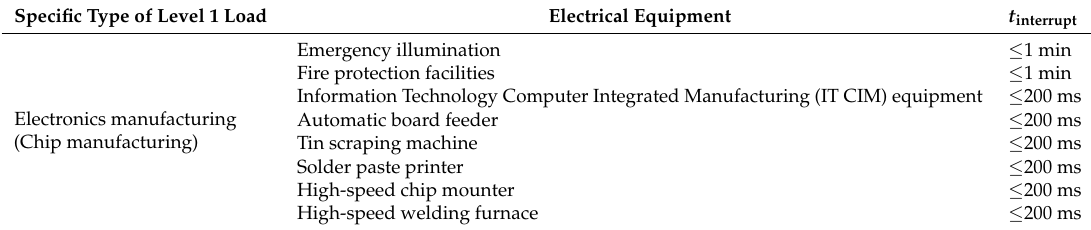
Table 3. t interrupt of electrical equipment in the electronics manufacturing